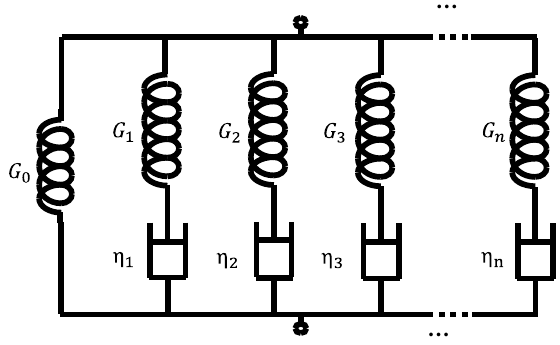
Figure 3. Generalized Maxwell model.